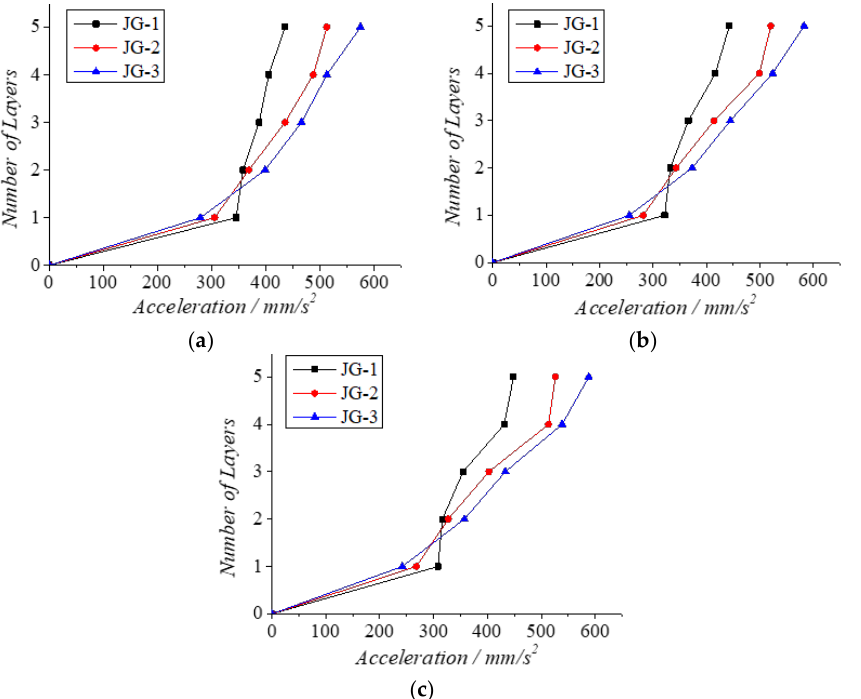
Figure 18. Maximum absolute acceleration response of each floor. ( a ) Under the action of EL-Centro wave; ( b ) under the action of Taft wave; ( c ) under the action of TJYY wave.